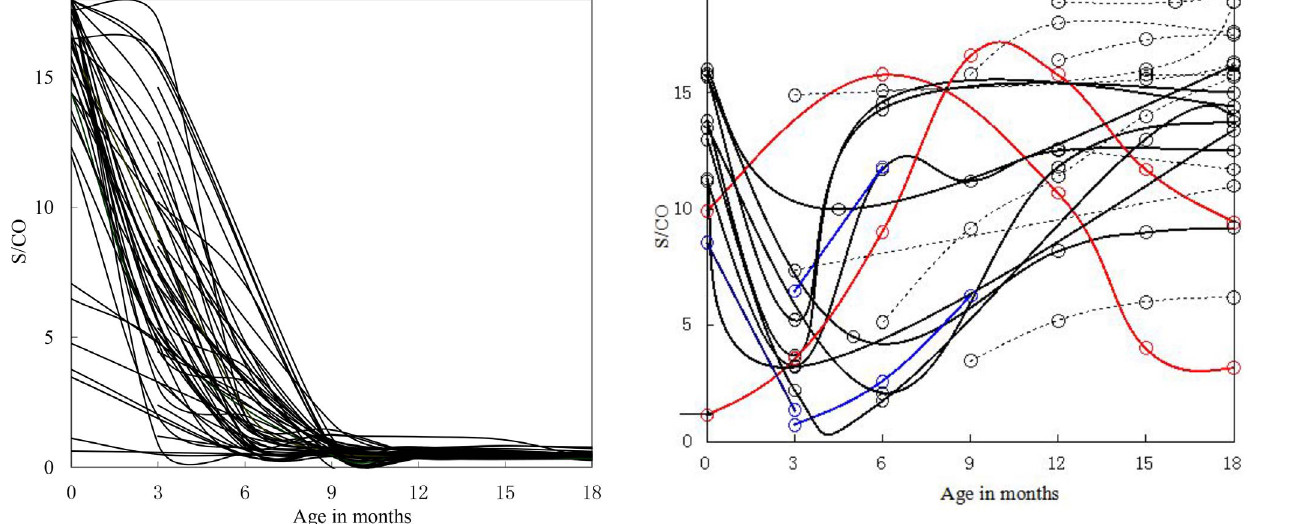
Figure 1. Anti-HIV S/CO values of uninfected infants at individual level. The arrow indicates S/CO=1. The figure was derived from 312 DBSs of 56 uninfected infants whose HIV antibody S/CO values at the following months of age are available: 0 to 6, 6 to 9, 9 to 12, and 12 to 18.